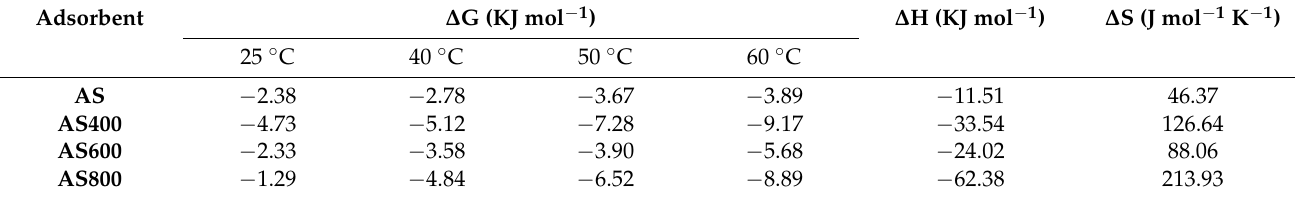
Table 5. Thermodynamic parameters for phenol adsorption by different alum sludge